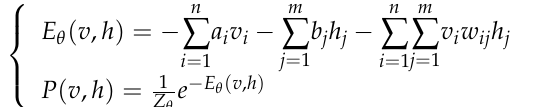
In the formula, v i and h j are the state vectors of the visible layer and the hidden layer, respectively; a i and b j are the bias vectors of the visible layer and the hidden layer, respectively; n and m are the units number of the visible layer and the hidden layer, respectively; w ij is the weight between v i and h j ; θ = ( a i , w ij , b j ) is the parameters of the model; and Z θ is the normalization